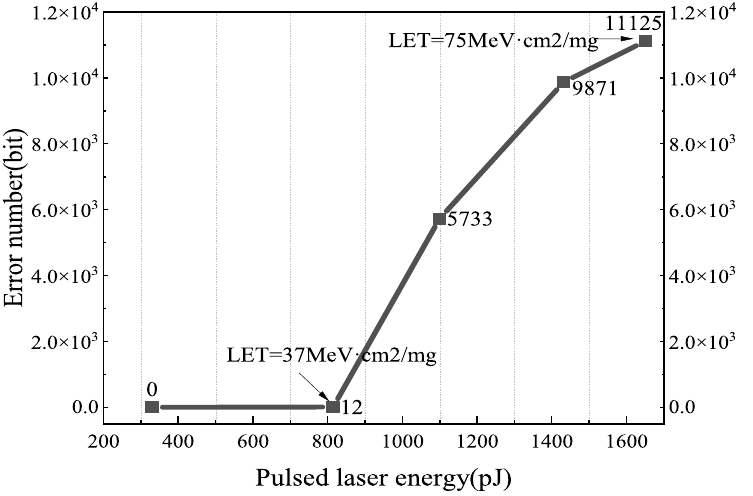
Figure 6. Error number curve with pulsed laser energy.